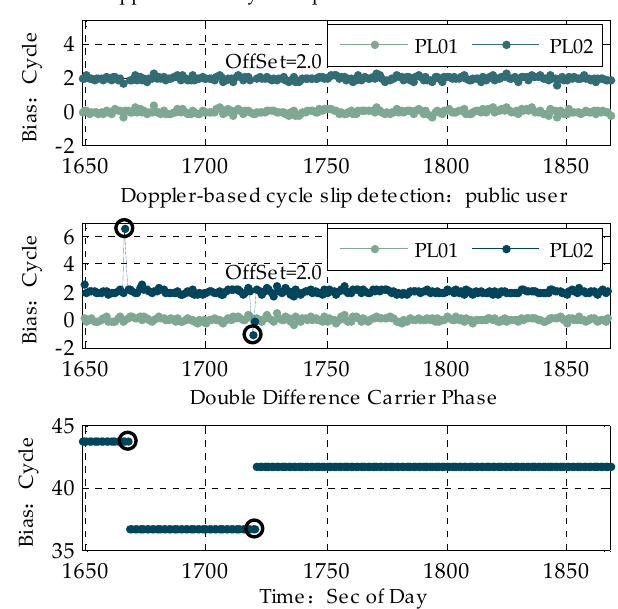
Figure 4. Cycle slip of PL01 and PL02.